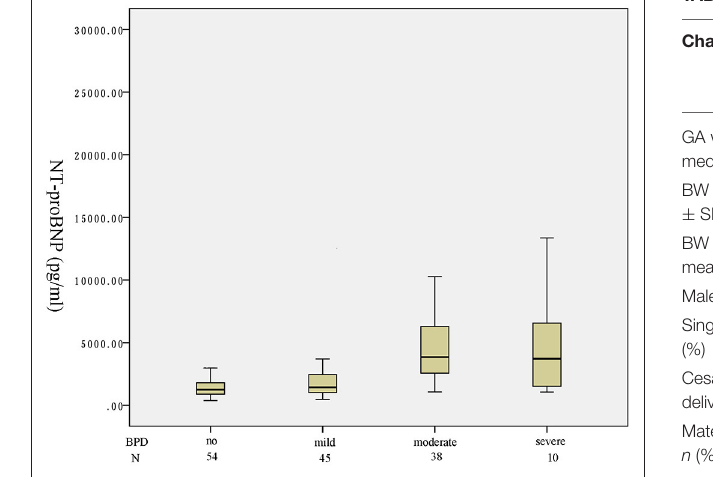
FIGURE 1 | Serum NT-proBNP levels in four different groups of BPD severity.